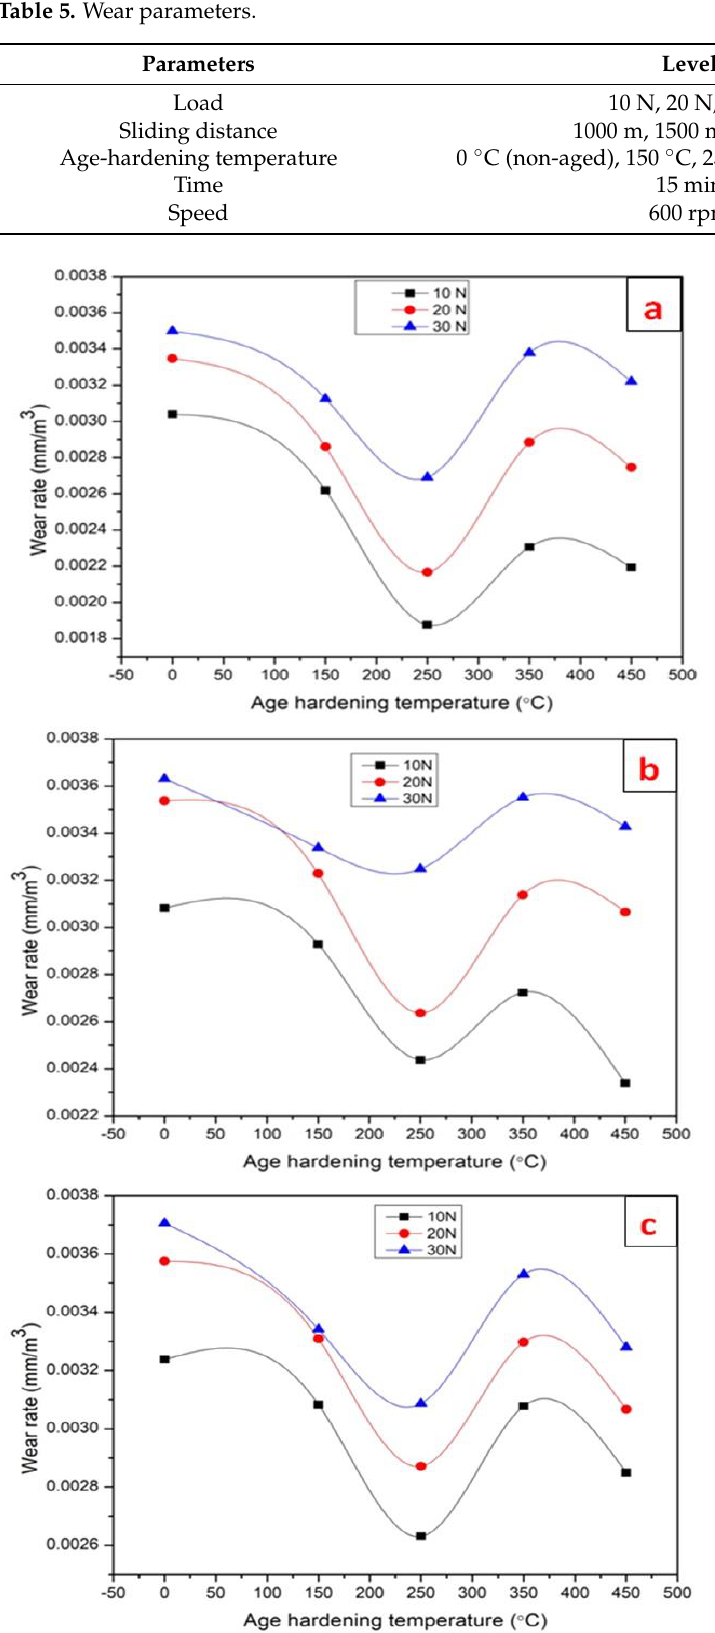
Figure 9. Wear rate of Al7075-WC composite with sliding distance of ( a ) 1000 m, ( b ) 1500 m; ( c ) 2000 m.